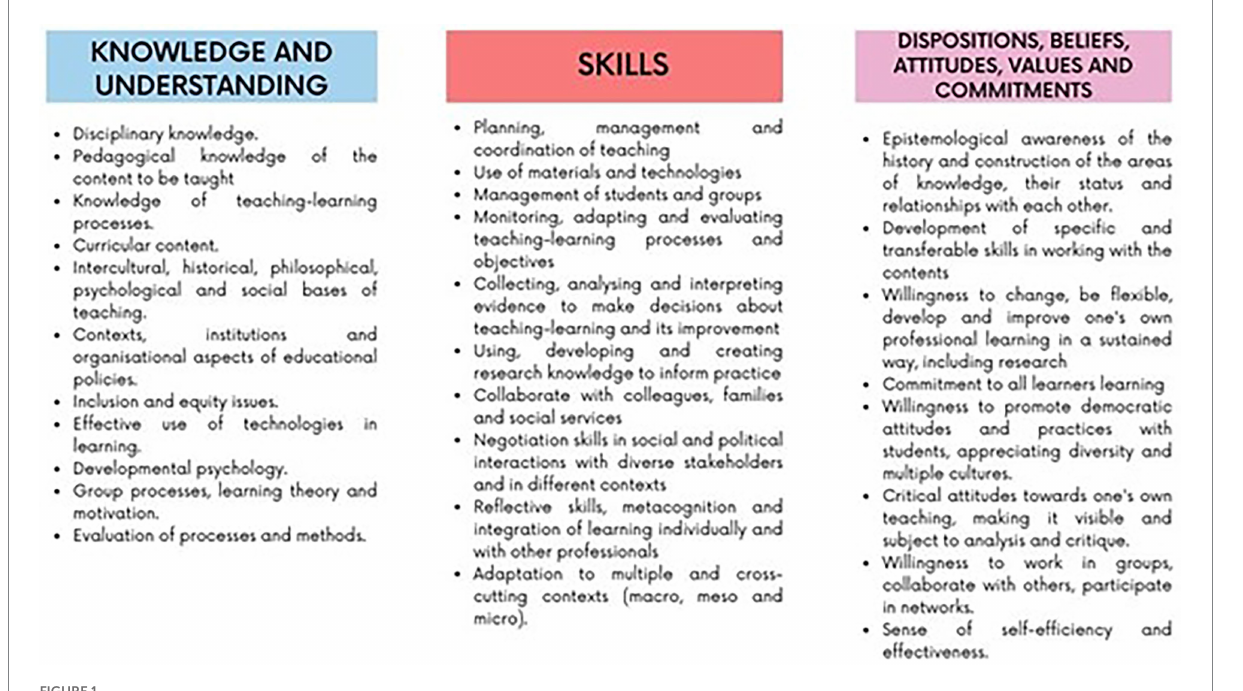
FIGURE 1 Key competencies for educators. Source: EU (2013, p.